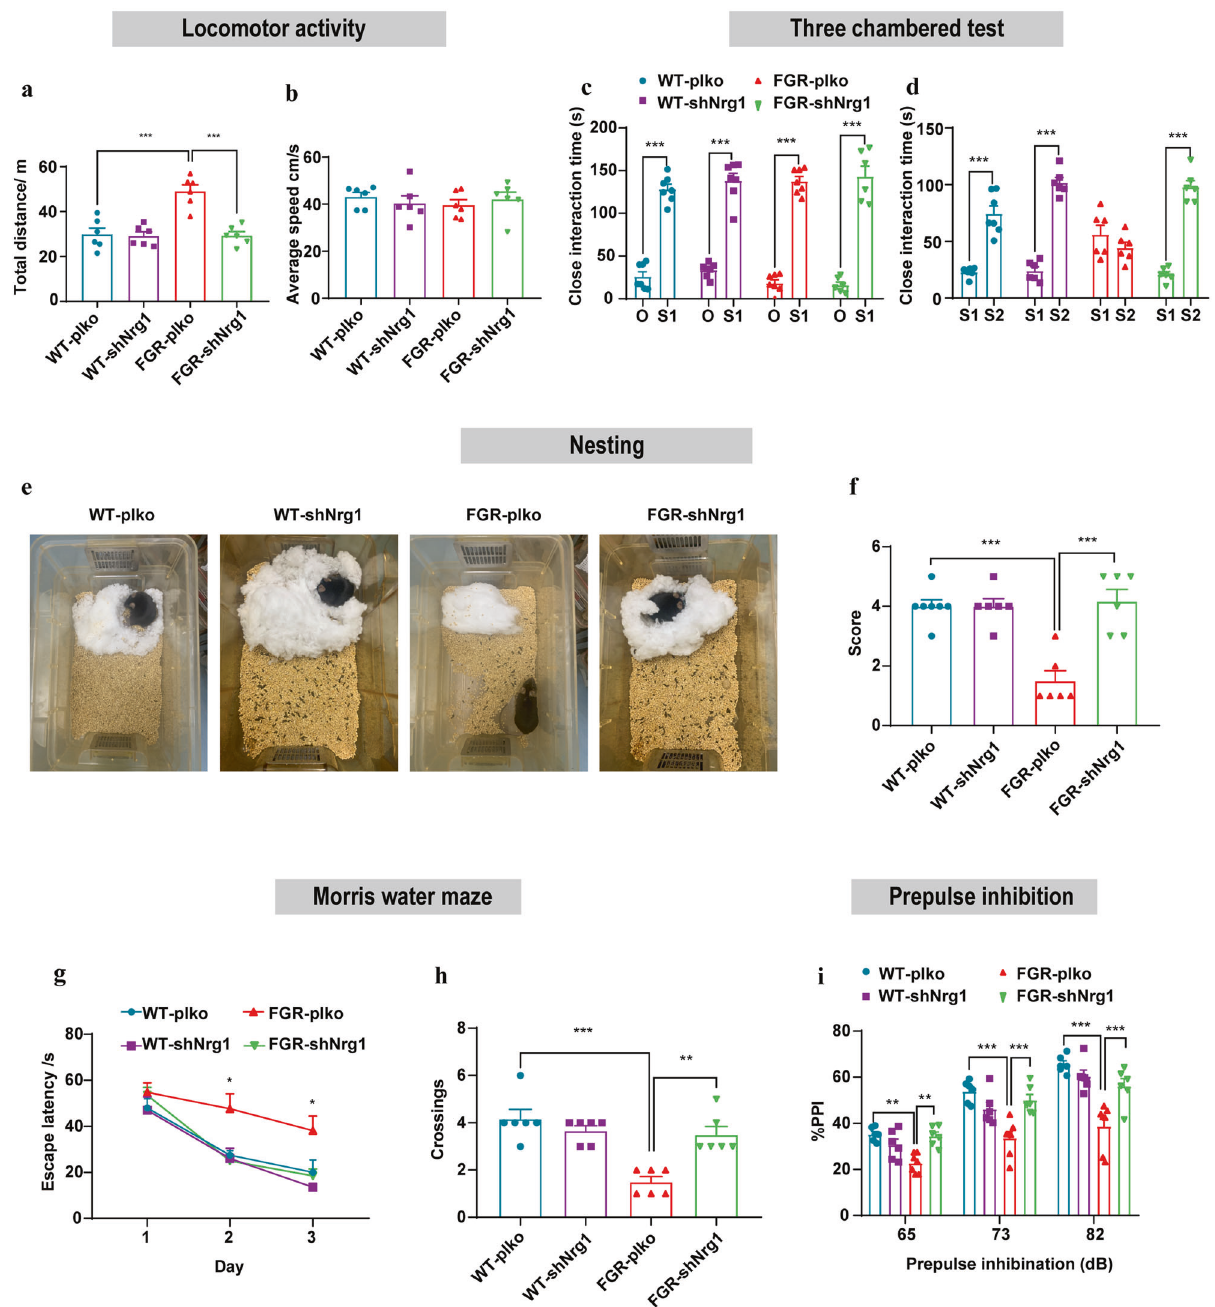
Fig. 5 NRG1 mPFC knockdown rescues FGR induced schizophrenia behavior. a , b Locomotor activity, n = 6 in each group. a Total distance. One-way ANOVA, WT-shCtrl vs FGR- shCtrl , P < 0.001; FGR- shCtrl vs FGR-shNRG1, P < 0.001. b Average speed. c Time spent on close interaction with an object (O) versus stranger mouse (S1) in the social approaching test. Two-way ANOVA , P WT- shCtrl < 0.001 ; P WT-shNRG1 < 0.001; P FGR- shCtrl < 0.001; P FGR-shNRG1 < 0.001. d Time spent on close interaction with a familiar mouse (S1) versus stranger mouse (S2) in the social novelty test. Two-way ANOVA, interaction time of each group spent with S2 than S1 ( P WT- shCtrl < 0.001; P WT-shNRG1 < 0.001; P FGR- shCtrl = 0.402; P FGR-shNRG1 < 0.001). e , f Nest building test of WT- shCtrl ( n = 7), WT-shNRG1 ( n = 6), FGR- shCtrl ( n = 6) mice, FGR-shNRG1 ( n = 6) mice. e Representative pictures of nests. f Nesting score. One-way ANOVA,WT- shCtrl vs FGR- shCtrl , P < 0.001; FGR- shCtrl vs FGR- shNRG1, P < 0.001. g , h MWM performance, n = 6 in each group. g Spatial acquisition performance. Two-way ANOVA, day2: WT- shCtrl vs FGR- shCtrl, P = 0.01; FGR- shCtrl vs FGR-shNRG1, P = 0.003. day3: WT- shCtrl vs FGR- shCtrl, P = 0.02; FGR- shCtrl vs FGR-shNRG1, P = 0.01). h Platform crossing. One-way ANOVA, WT- shCtrl vs FGR- shCtrl , P < 0.001; FGR- shCtrl vs FGR-shNRG1, P < 0.001. i Prepulse inhibition test of WT- shCtrl ( n = 6), WT - shNRG1 ( n = 6), FGR- shCtrl ( n = 7) mice, FGR-shNRG1 ( n = 6) mice. PPI of four mice groups. Two-way ANOVA, 65db: WT- shCtrl vs FGR- shCtrl, P = 0.004; FGR- shCtrl vs FGR-shNRG1, P = 0.008. 73db: WT- shCtrl vs FGR- shCtrl, P < 0.001; FGR- shCtrl vs FGR-shNRG1, P < 0.001. 82db: WT- shCtrl vs FGR- shCtrl, P < 0.001; FGR- shCtrl vs FGR-shNRG1, P < 0.003. The results are expressed as mean ± SD.; * P < 0.05, ** P < 0.01, and *** P < 0.001.